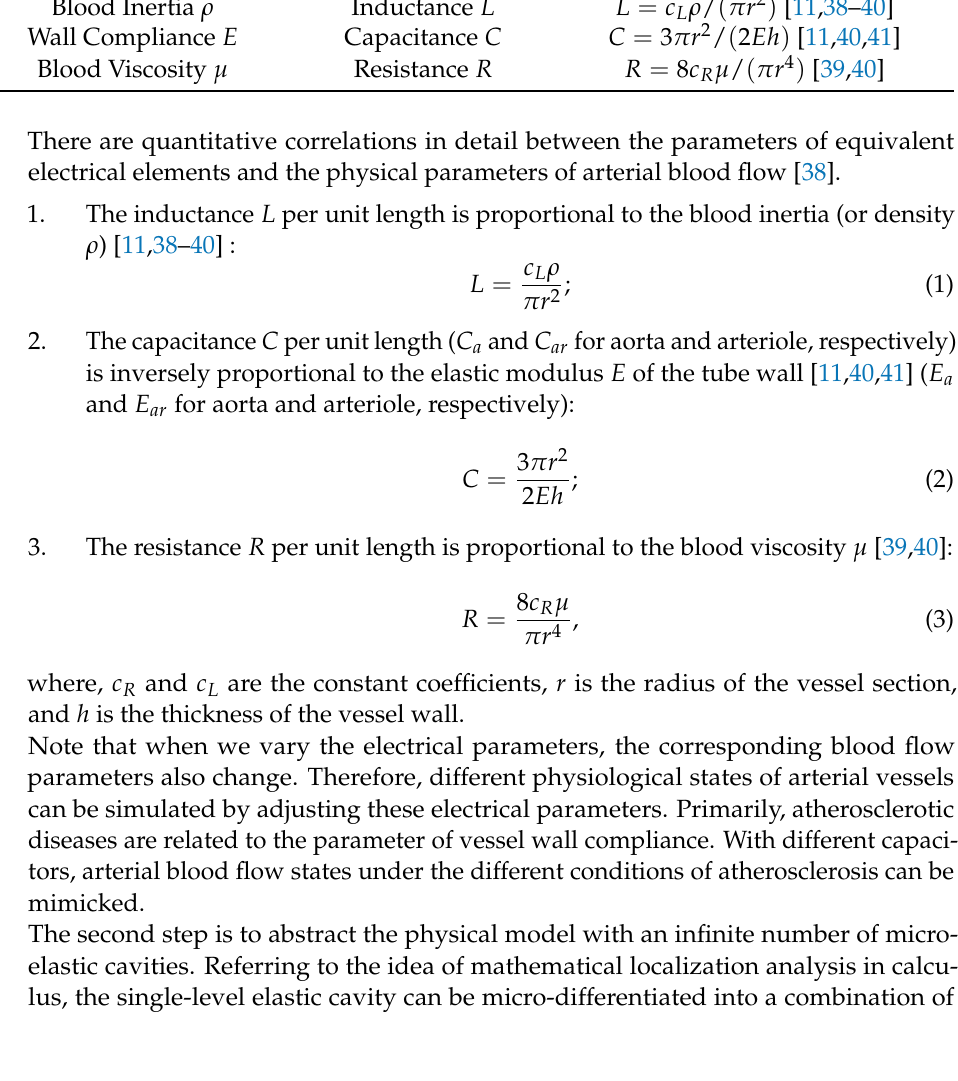
Table 1. Correspondence table of the analogy between electric and hemodynamic networks. Hemodynamic Electric Quantitative Correlation Pressure P Voltage U P = U Flow Rate Q Current I Q = I Blood Inertia ρ Inductance L L = c L ρ / ( π r 2 ) [11,38–40] Wall Compliance E Capacitance C C = 3 π r 2 / ( 2 Eh ) [11,40,41] Blood Viscosity µ Resistance R R = 8 c R µ / ( π r 4 )